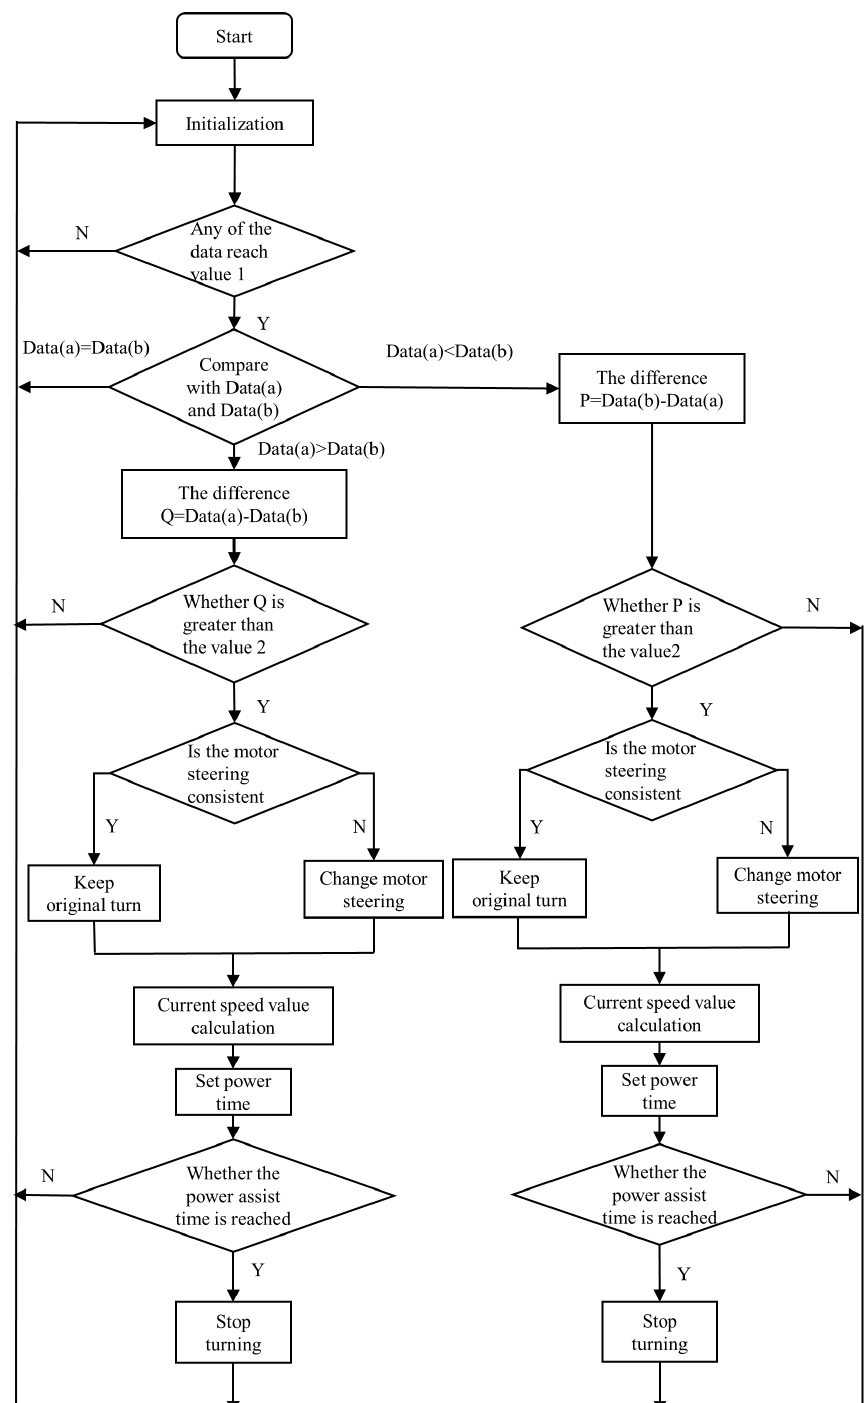
Figure 6. Flowchart of the EMG-based compensation